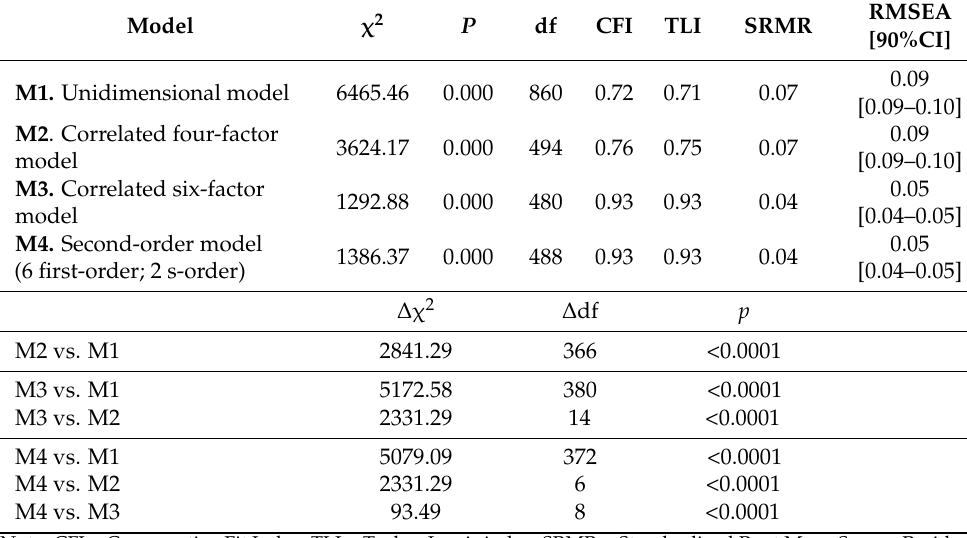
Table 4. Goodness of fit of alternative BAT